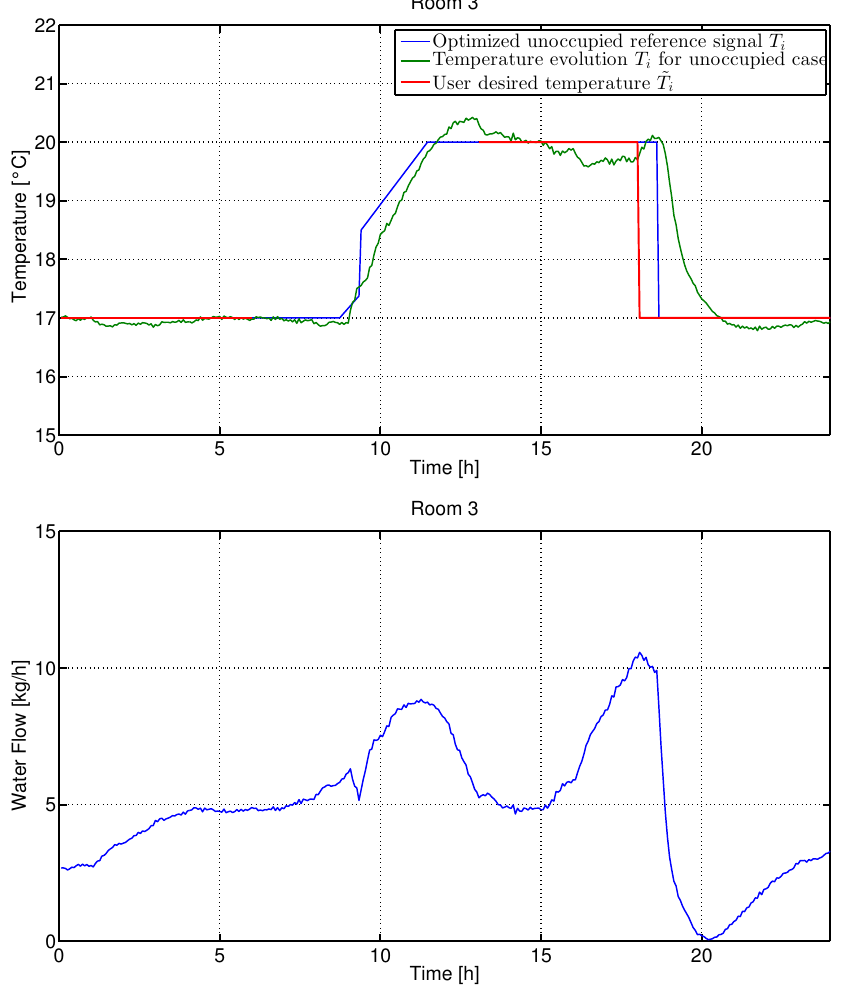
Figure 11. One day simulation, 5 December, for room 3 with radiators in case of no set-point given by the user for given time intervals (ARMAX